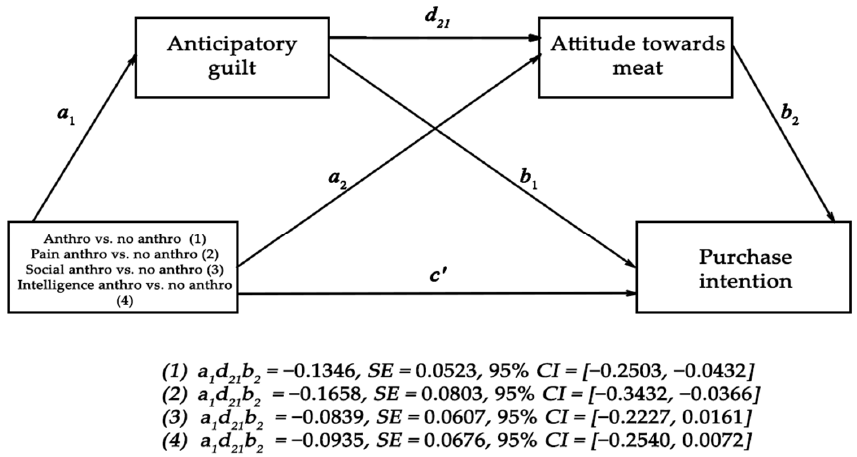
Figure 6. The effect of anthropomorphism (intelligence, pro-social and pain) vs. no anthropomor- phism (control and just cow) on purchase intentions is serially mediated via anticipatory guilt and attitude towards meat (Study 1).